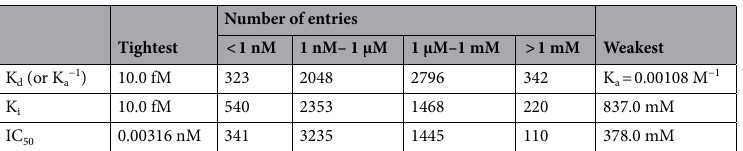
Table 1. The distribution of K d , K i , and IC 50 in Binding MOAD.